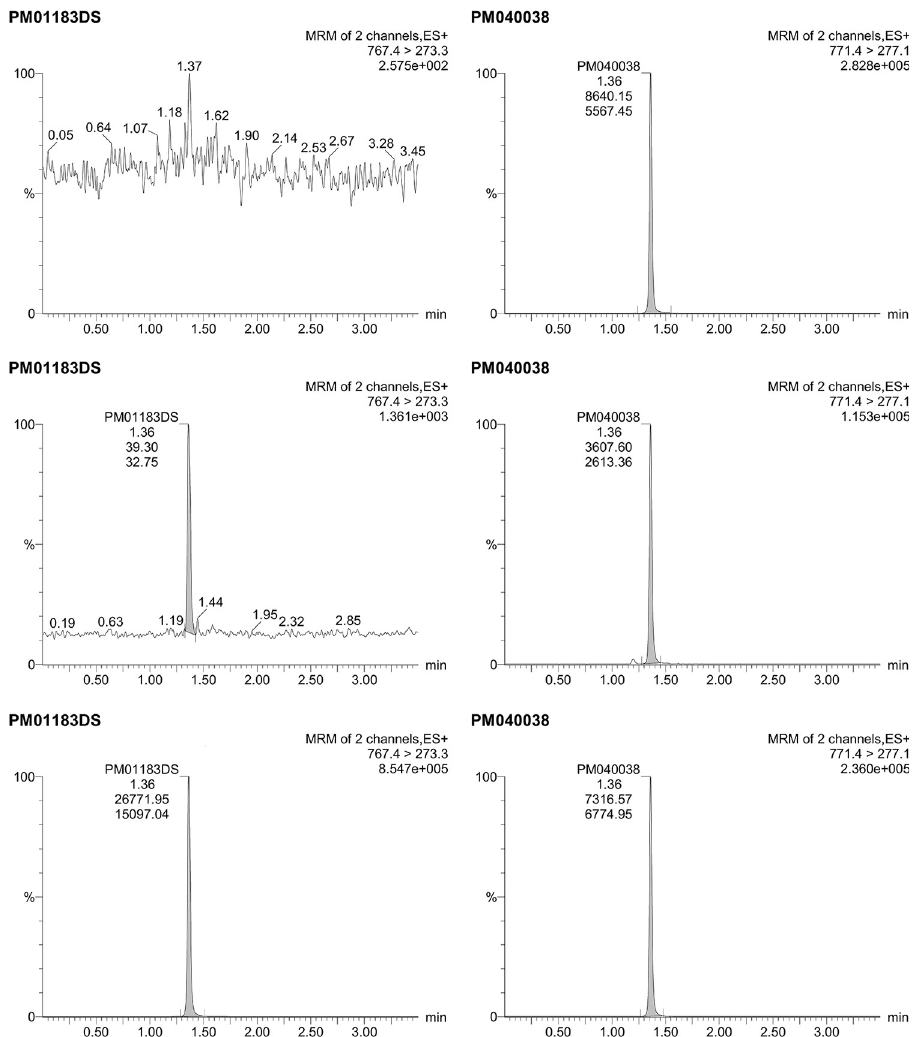
Fig 2. Chromatogram of Lurbinectedin Blank (upper), LLOQ (middle), and a Treated Patient (lower) Plasma Samples (with a lurbinectedin concentration of 177 ng/mL), With Internal Standard (right). ES+, positive mode electrospray ionization; LLOQ, lower limit of quantitation; MRM, multiple reaction monitoring.